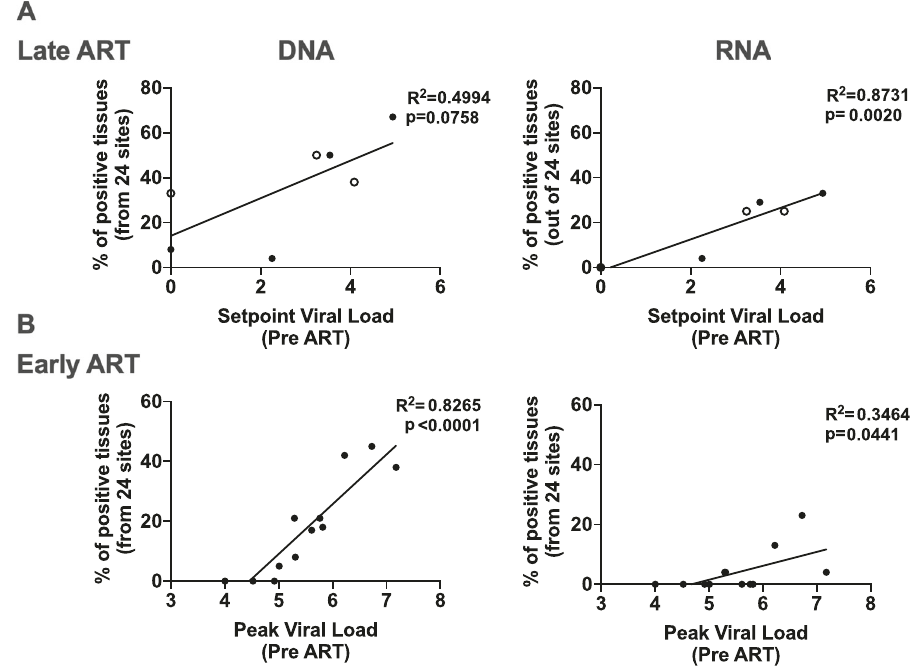
Fig. 3 Associations between pre-ART viral loads and tissue-associated peak viral loads. A Linear relationships between pre-ART plasma viral loads and tissue positivity for the ( A ) Late ART and ( B ) Early ART monkey cohorts. The setpoint viral loads at week 0 and the peak viral loads at week 1 were used for the Late ART and Early ART linear regressions, respectively. Each circle is a monkey and open circles denote SHIV-SF162P3 infected animals in the Late ART study. R squared and p values were derived using a simple linear regression model. A B